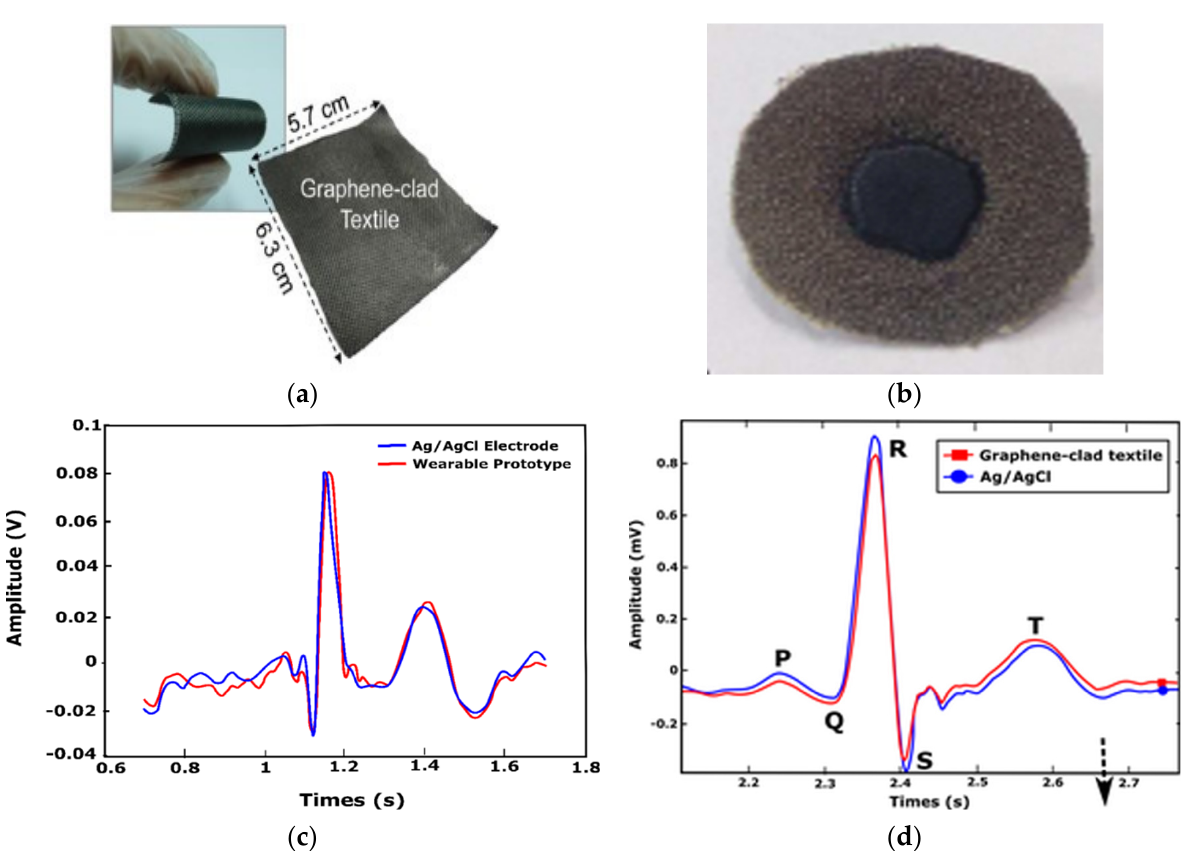
Figure 6. Examples of graphene-coated textile ECG electrodes and resulting signals: ( a ) photograph of a sample grapheme- clad nylon fabric for ECG electrode, adopted from [63]; ( b ) graphene-coated polyester fiber electrode, adopted from [25]; ( c ) ECG signals recorded from conventional Ag/AgCl electrodes and the graphene-clad textile with wristband, adopted from [39]; and ( d ) filtered ECG signals from Ag/AgCl and graphene-clad textile electrodes, adopted from [63].